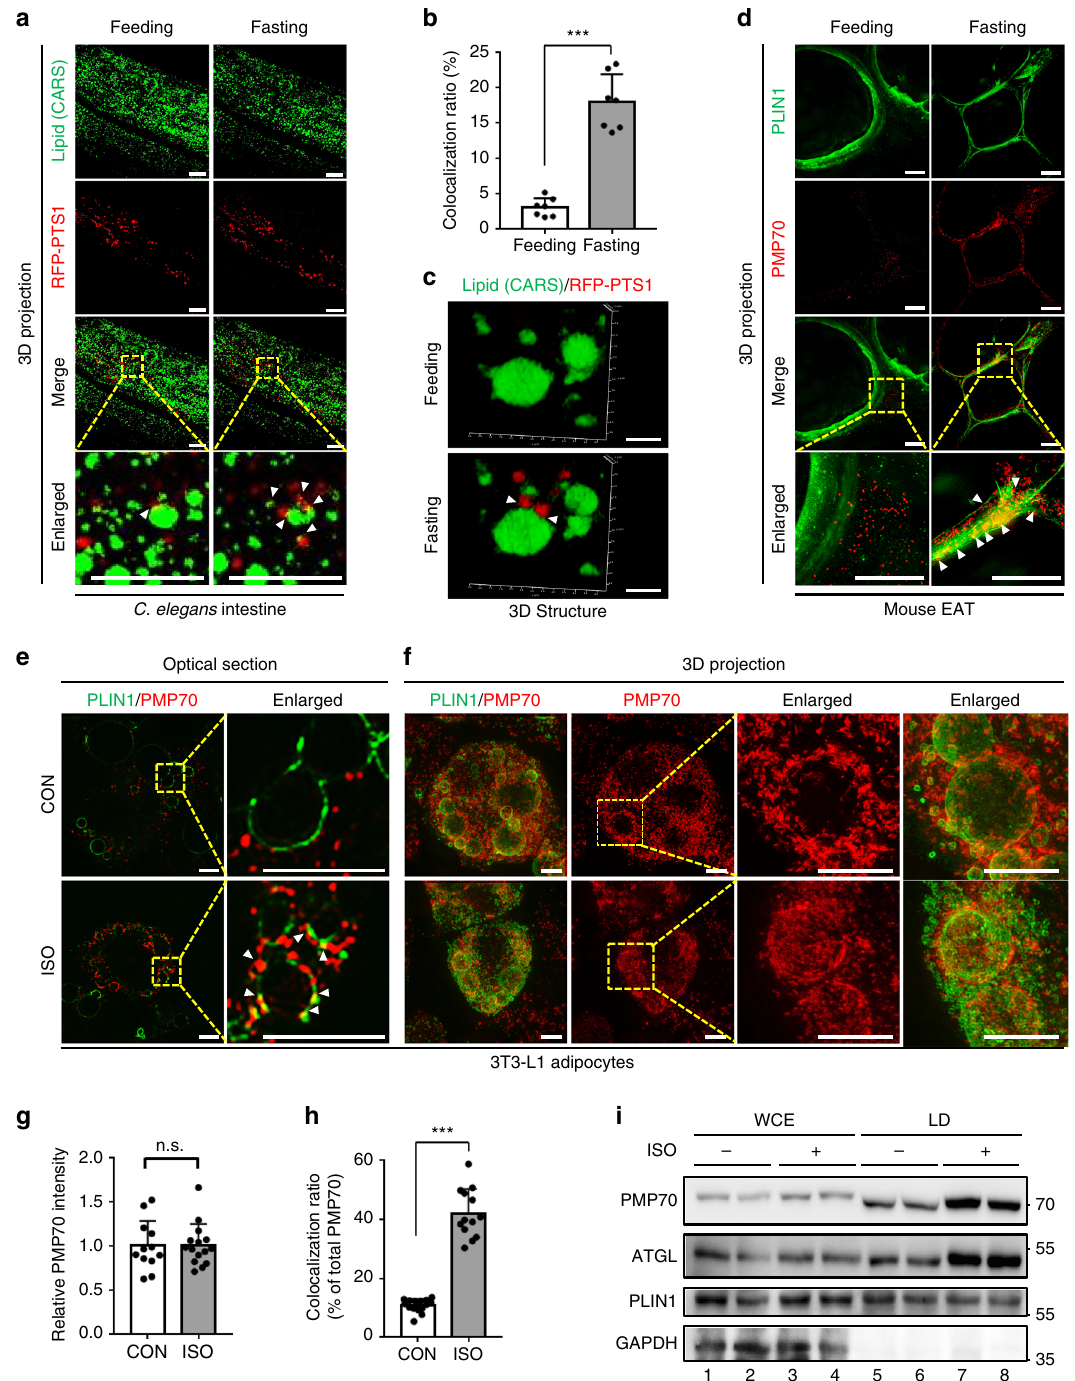
Fig. 1 Fasting stimuli promote the interaction between PER – LD. a Representative CARS live images of peroxisome – LD contacts (arrowhead) during fasting (1 h) in young adult worms expressing RFP::PTS1 (peroxisome marker). b Quanti fi cation of peroxisome – LD colocalization calculated using Leica software (LAS X). n = 7 worms. c Representative 3D structural images of peroxisome – LD contact (arrowhead) during fasting in C. elegans . Scale bars, 5 μ m. d 3D-SIM images of eWAT immunostained with PLIN1 (LD marker, green) and PMP70 (peroxisome marker, red) under feeding and fasting (12 h) conditions. e Representative optical section images of peroxisome – LD contacts (arrowhead) in differentiated 3T3-L1 adipocytes stained for endogenous PMP70 (red) and PLIN1 (green) and treated with ISO (1 μ M) for 1 h. f 3D projection of SIM images in differentiated 3T3-L1 adipocytes immunostained for PMP70 (Red) and PLIN1 (green) and treated with ISO (1 μ M) for 1 h. g Quanti fi cation of PMP70 staining intensity in adipocytes treated with or without ISO (1 μ M) for 1 h. n = 12 cells for CON; n = 15 cells treated with ISO. h Quanti fi cation of peroxisome – LD colocalization calculated using imageJ software. n = 15 cells for each group. i Western blot of whole cell extracts (WCE) or LD fractionation for PMP70 (peroxisome) and LD-associated proteins. 30 μ g of protein from WCE; 20 μ g of protein from LD fraction. CON control; ISO isoproterenol. All scale bars, 10 μ m except for c . Arrowhead: contact between PER – LD. Data are represented as the mean ± SD; * P < 0.05, *** P < 0.001 (unpaired two-tailed Student ’ s t -test). n.s., not statistically signi fi